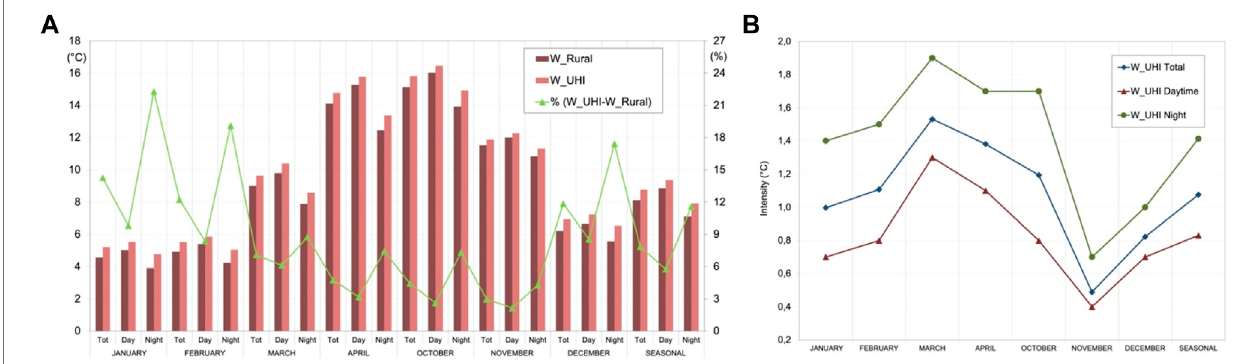
FIGURE 10 | Monthly and seasonal average air temperatures of rural and urban weather in case UHI_1 or UHI_2 in the three daily periods and their percent differences (A) in summer. The corresponding UHI intensities are shown in panel (B) .